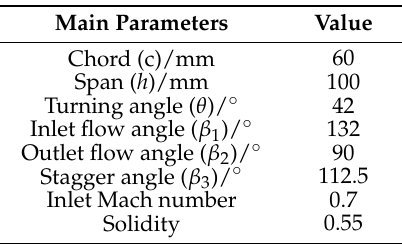
Table 1. Main parameters of NACA65-K48 high-speed compressor cascade.